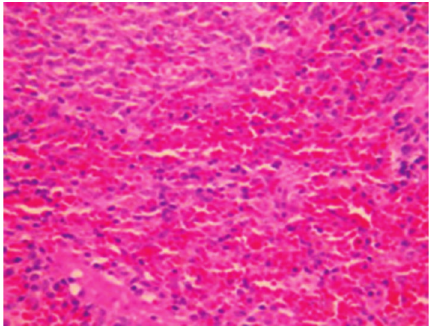
Figure 12: Sham-operated group 28 days; hyperplasia of sinus cell and inflammatory cell infiltration in lymph node; HE × 200.